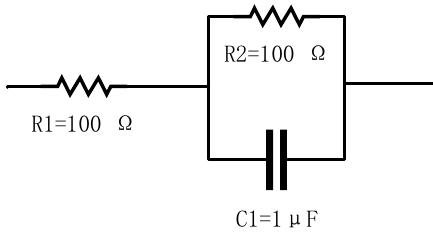
Figure 4. The circuit model as sample under test.